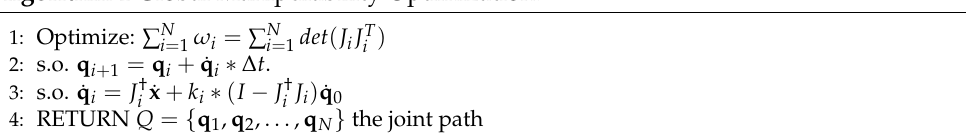
Algorithm 1 Global Manipulability